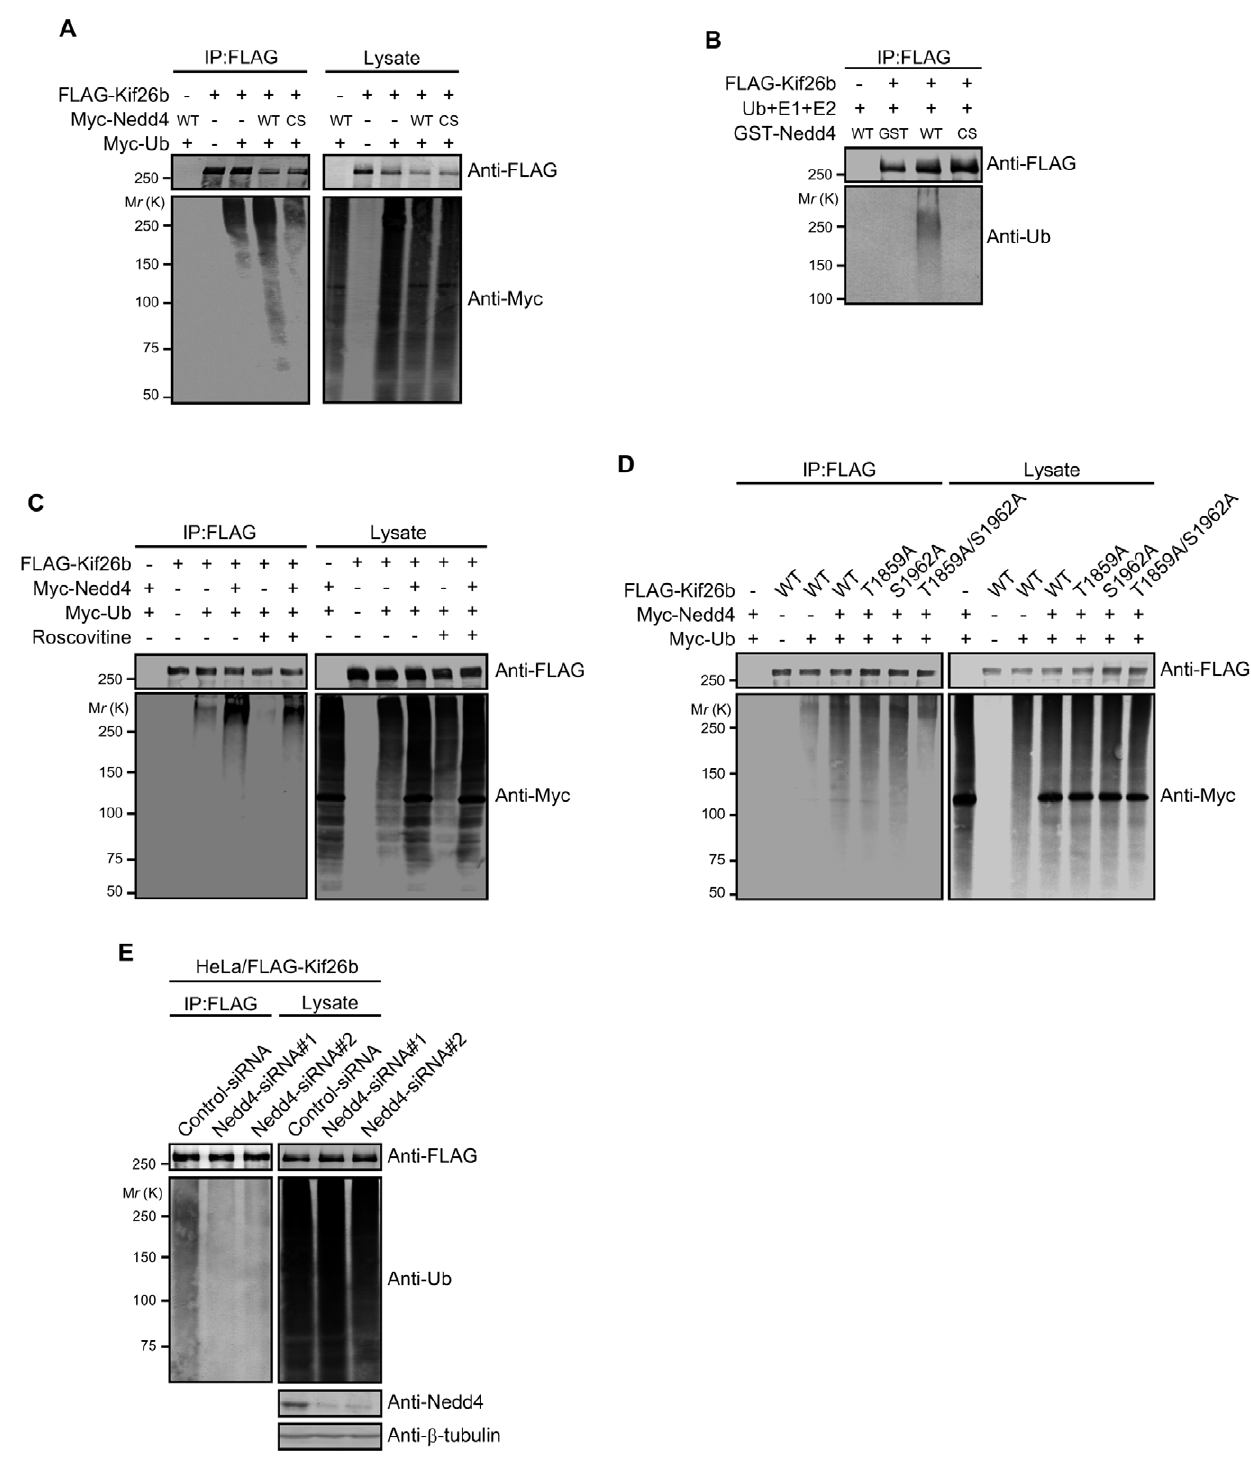
Figure 4. Ubiquitination of Kif26b is promoted by Nedd4. A . HEK293 cells were transfected with the indicated plasmids. At 48 h after post- transfection, the cells were treated for 8 h with MG132 (20 m M) and the FLAG-tagged proteins were then immunoprecipitated from the cell lysates with anti-FLAG beads. The precipitates were analyzed by immunoblotting with the indicated antibodies. B . HEK293 cells were transfected with FLAG- Kif26b. The FLAG-tagged proteins were immunoprecipitated from the cell lysates with anti-FLAG M2 beads, and the precipitates were used for in vitro ubiquitination assays with GST or GST-Nedd4 proteins (wild-type [WT] or catalytically inactive [CS]). The reaction mixtures were subjected to immunoblotting with the indicated antibodies. C . HEK293 cells were transfected with the indicated plasmids. At 48 h after post-transfection, the cells were pretreated for 3 h with DMSO or Roscovitine (20 m M) and then further treated for 8 h with MG132 (20 m M). The FLAG-tagged proteins were then immunoprecipitated from the cell lysates with anti-FLAG beads and subjected to immunoblotting with the indicated antibodies. D . HEK293 cells were transfected with the indicated plasmids. At 48 h after post-transfection, the cells were treated as in A and then the FLAG-tagged proteins were